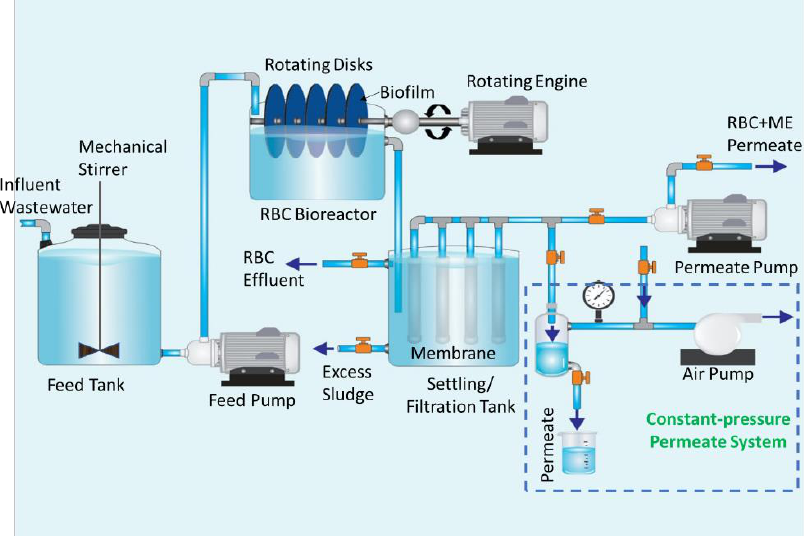
Figure 1. Schematic diagram of RBC-ME configuration.